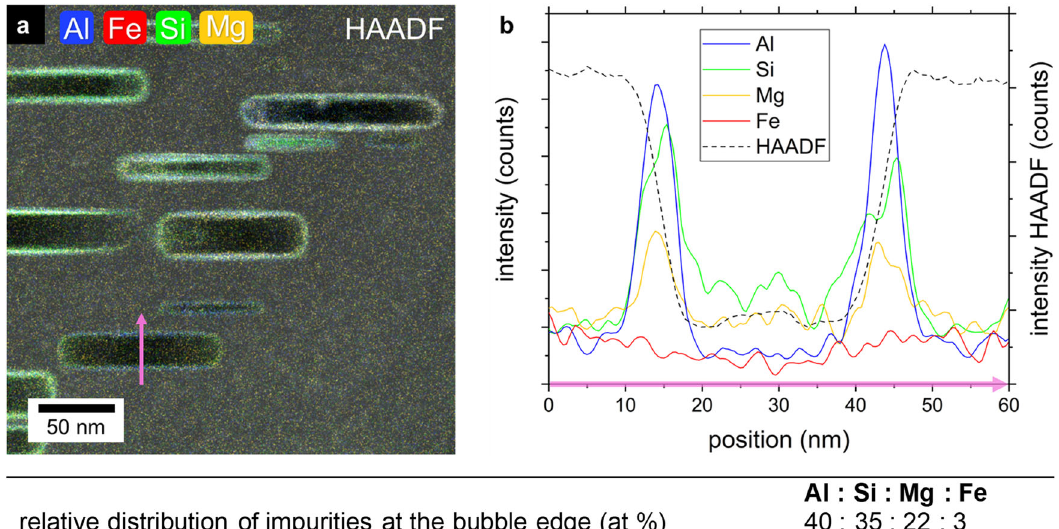
Fig. 5 Accumulation of impurities at bubble walls. a EDX scan of bubbles in beryllium with overlaid high-angular annular dark- fi eld (HAADF). The elements Al, Mg and Si can be found at the bubble surface. The concentration pro fi le of the major impurity, iron, is plotted for comparison. The purple arrow marks the extraction position for the concentration pro fi les shown in b 68 .